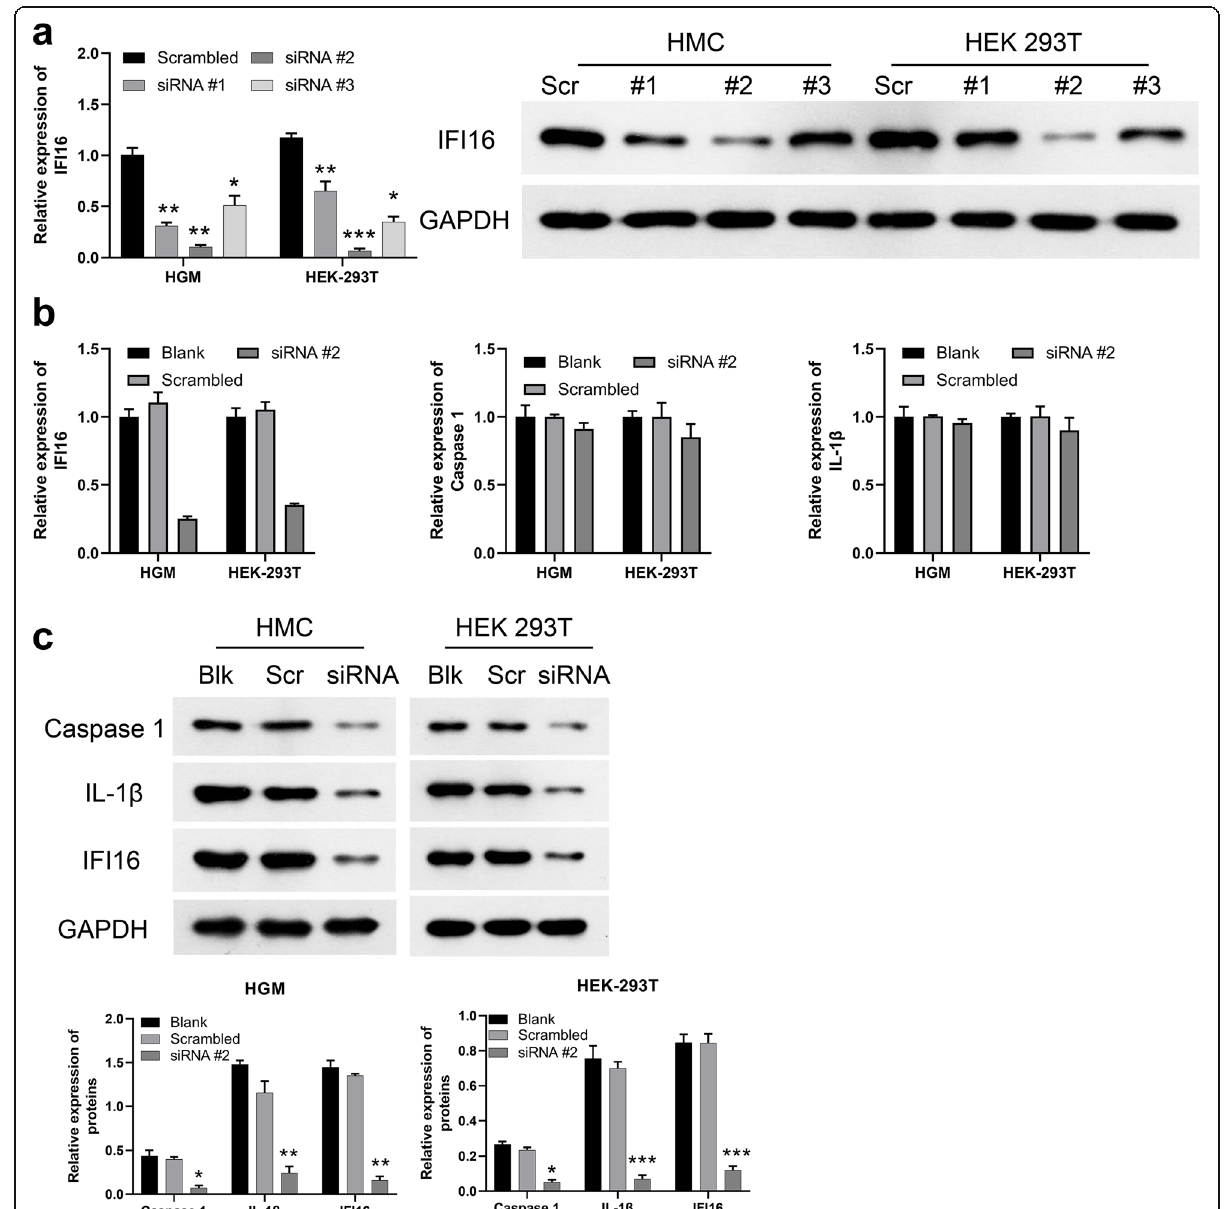
Fig. 4 Down-regulation of IFI16 reduced the expression of caspase-1 and IL-1ß in siIFI16 group compared those in NC and Blank group of the two cell lines,